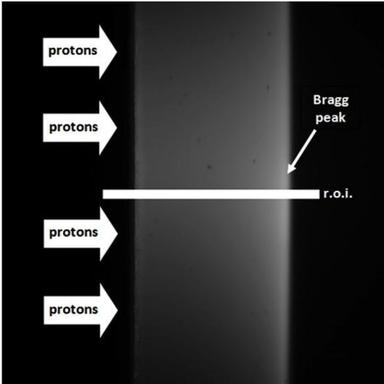
PL image of the 18 MeV Bragg curve stored in a LiF crystal.